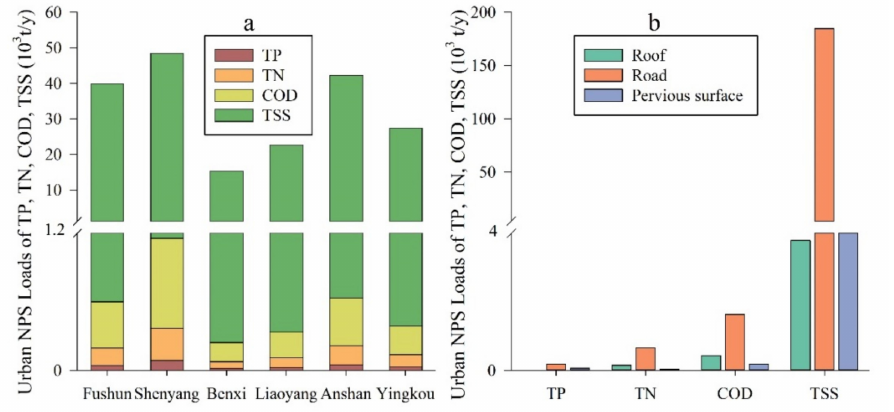
Figure 9. The average annual urban non-point source (NPS) pollutant loads of total phosphorus (TP), total nitrogen (TN), chemical oxygen demand (COD) and total suspended solids (TSS) of the six cities and different underlying surfaces. ( a ) The average annual pollutant loads of TP, TN, COD and TSS of the six cities; ( b ) The average annual pollutant loads of TP, TN, COD and TSS from roof, road and pervious